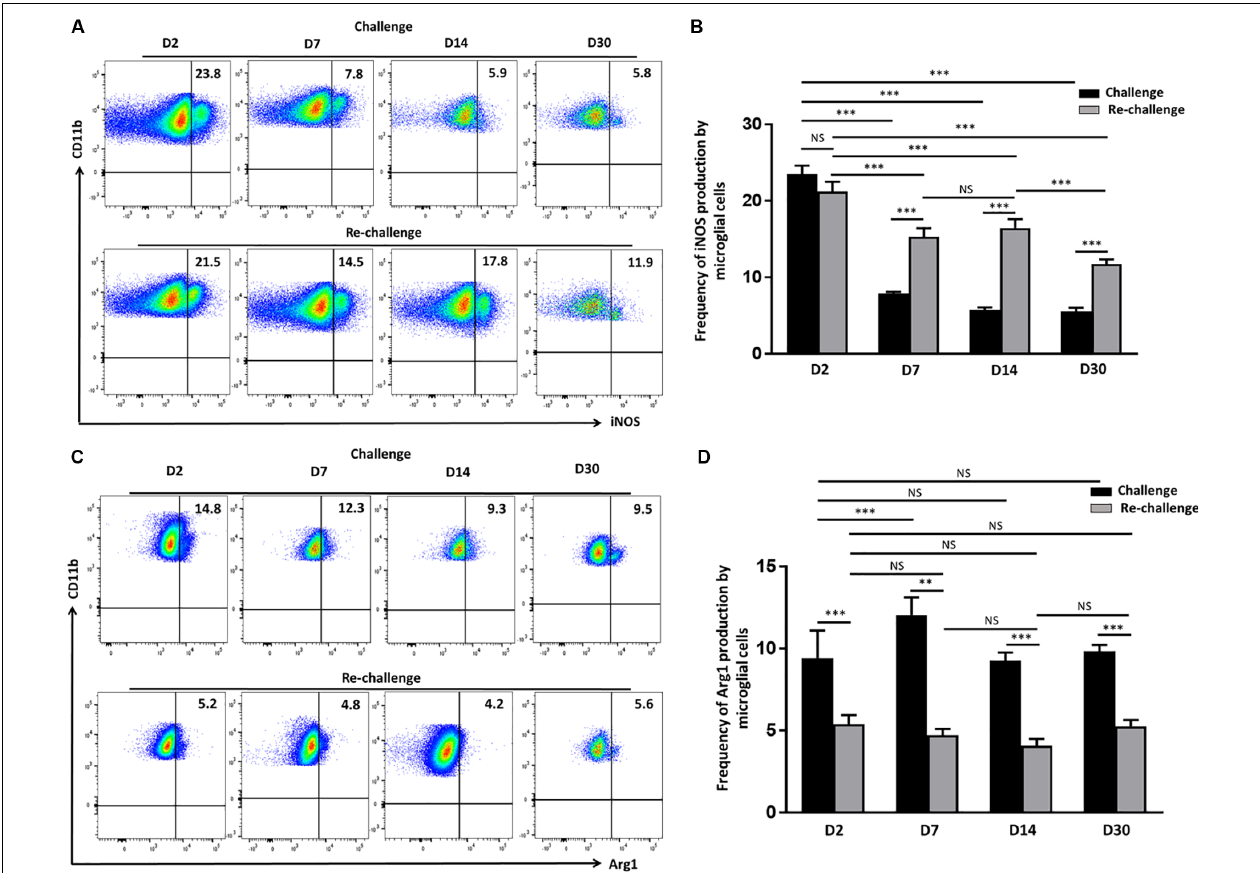
FIGURE 4 | Re-challenge with T-cell epitope peptide-induced prolonged inducible nitric oxide synthase (iNOS) production by reactive microglia. (A) Representative pseudocolor plots illustrate microglial cell iNOS production at d 2, 7, 14, and 30 post-challenge and re-challenge with cognate antigen. (B) Bar graph indicates